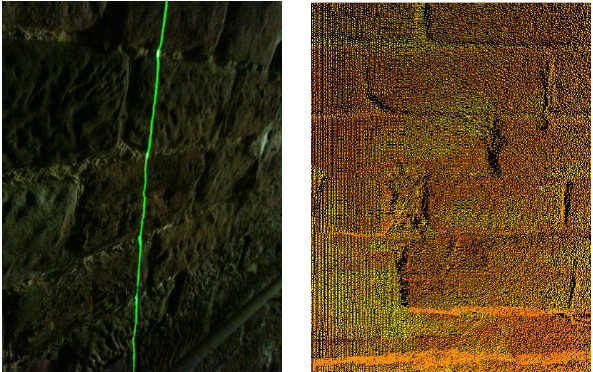
Figure 5: Example of laserscanning of a portion of side wall (left) and resulting point cloud